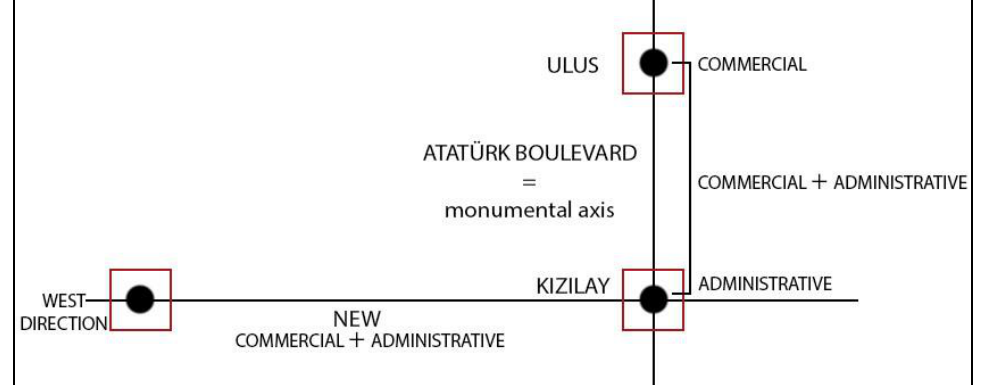
Figure 19 Space Syntax findings of the examined different periods.